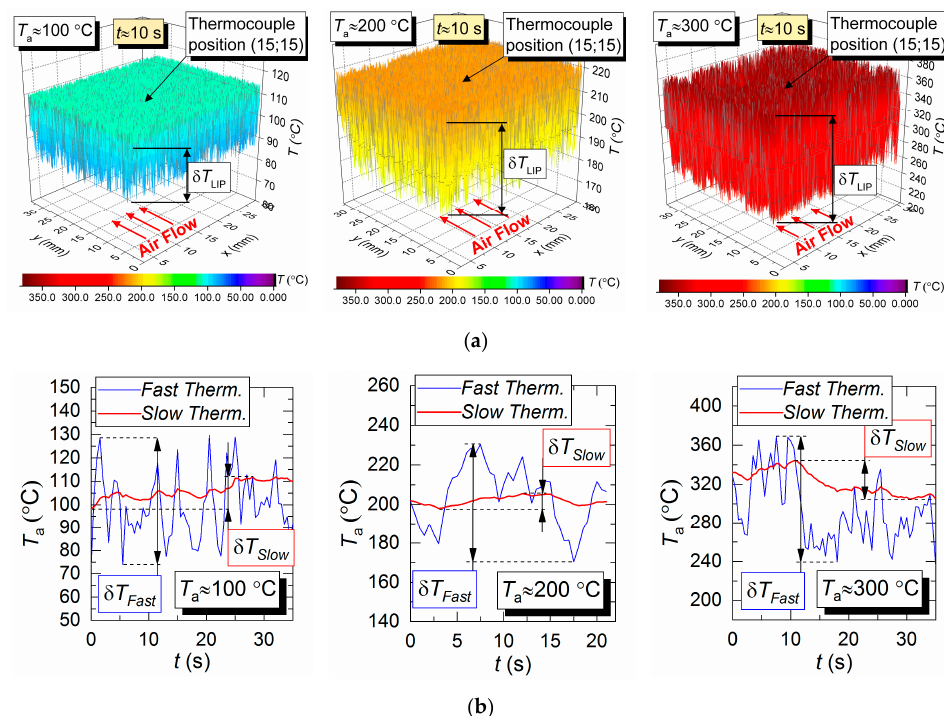
Figure 7. Temperature fields of combustion products flow (with no droplets present) obtained by LIP ( a ), as well as temperature variation trends obtained by two different thermocouples ( b ).